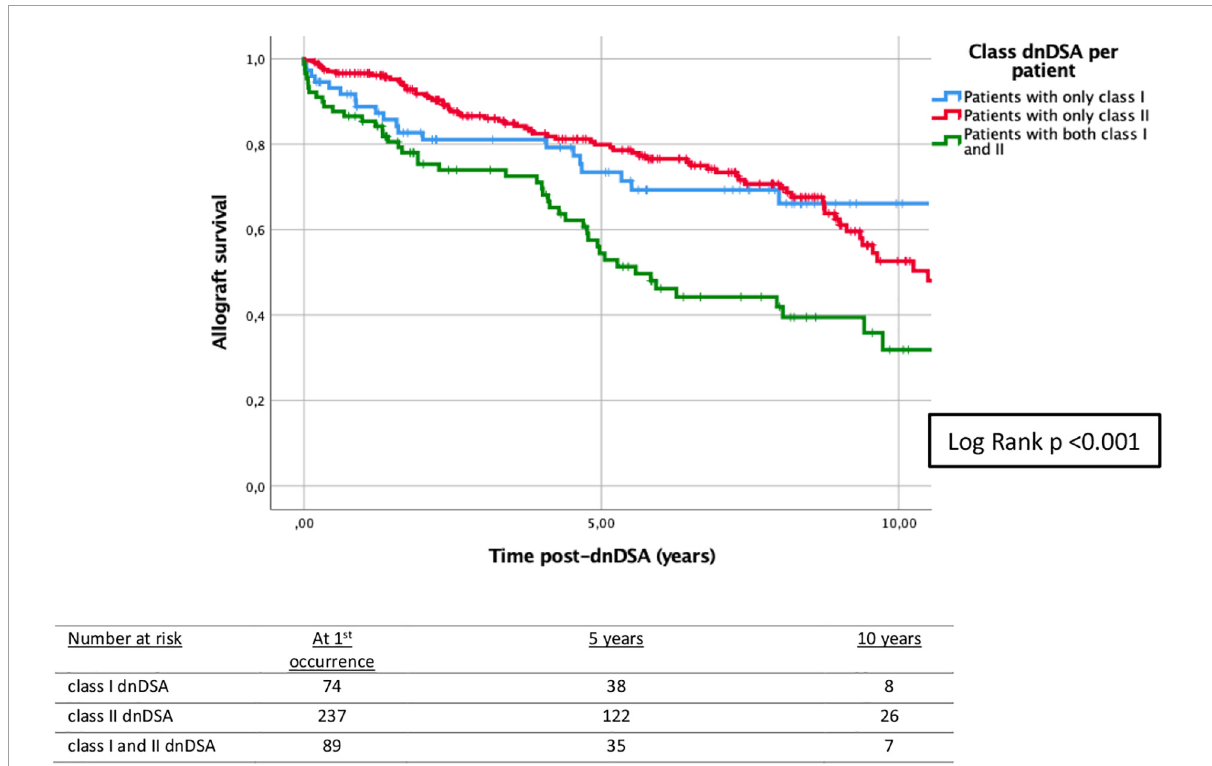
FIGURE2 Kaplan–Meier survival analysis of death-censored graft failure for HLA class of dnDSA after the first occurrence of the first dnDSA. Five-year death-censored allograft survival post-dnDSA: 73.4% ( ± 5.6%) for patients with class I dnDSA; 79.9% ( ± 2.9%) for patients with class II dnDSA; and 54.4% ( ± 5.9%) for patients with both class I and II dnDSA. Log-rank test p < 0.001. dnDSA, de novo donor-specific